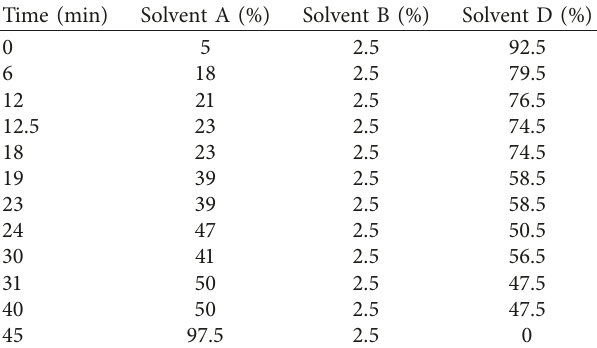
Table 2: The gradient program for simultaneous quantification of main flavonoids and phenolic acids in